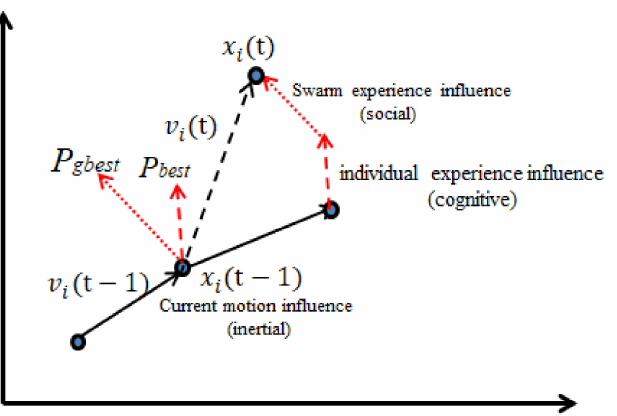
Figure 2. Attack path reconstruction using a particle swarm optimisation (PSO) scheme [13].